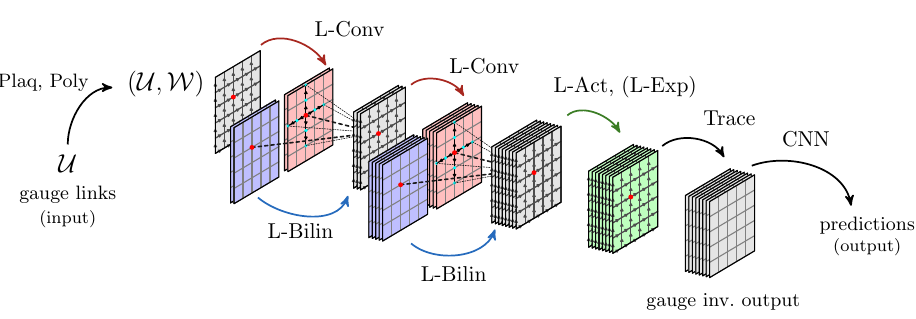
Figure 1: A possible L-CNN architecture. Figure from